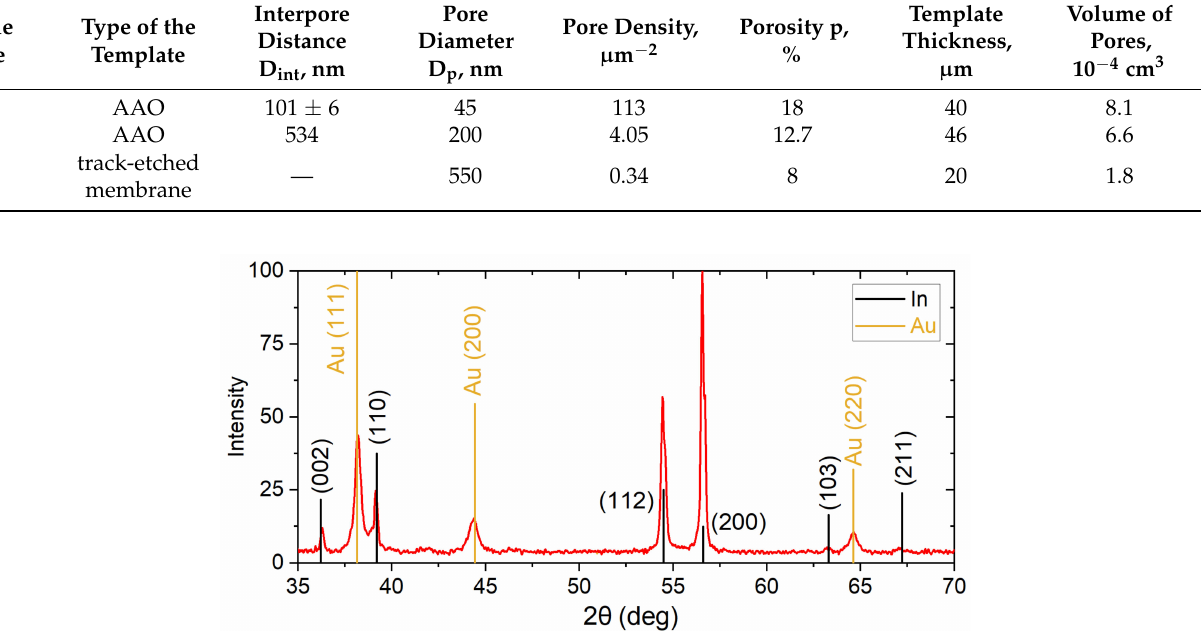
Figure 4. XRD pattern for AAO/In nanocomposite containing array of nanowires with 200 nm